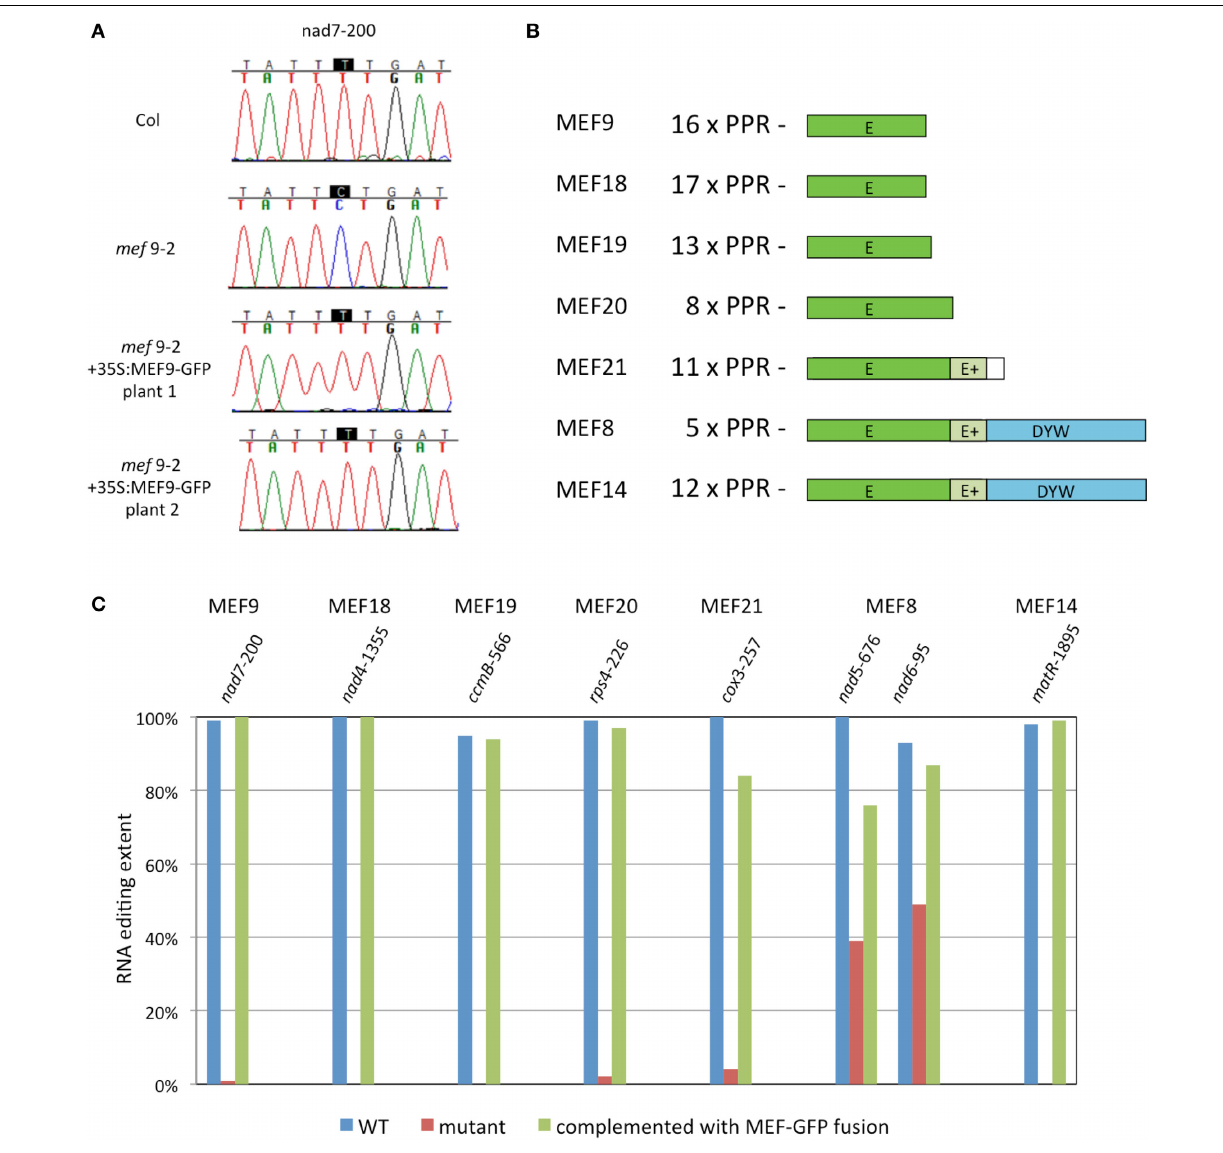
an additional extension termed E + . The white box in MEF21 indicates an extension of the open reading frame beyond the E/E + domains but without similarity to the DYW region. (C) Bar graph of the complementation levels achieved at respective target sites in mutant plant lines transformed with the corresponding chimeric MEF-GFP proteins. Shown are the maximal editing levels observed in at least 1 of the 11 or 12 transgenic plant lines analyzed for each mutant. Arabidopsis thaliana plants were grown, transformed and analyzed as described (Zehrmann et al., 2009; Verbitskiy et al., 2012a). Chimeric gene constructs were cloned under control of the 35S promoter. Individual transformants were selected and propagated independently. RNA editing was verified by cDNA sequence analysis in each transgenic plant line, percentages of editing were calculated by relative peak heights of C and T sequence signals, respectively (Zehrmann et al.,